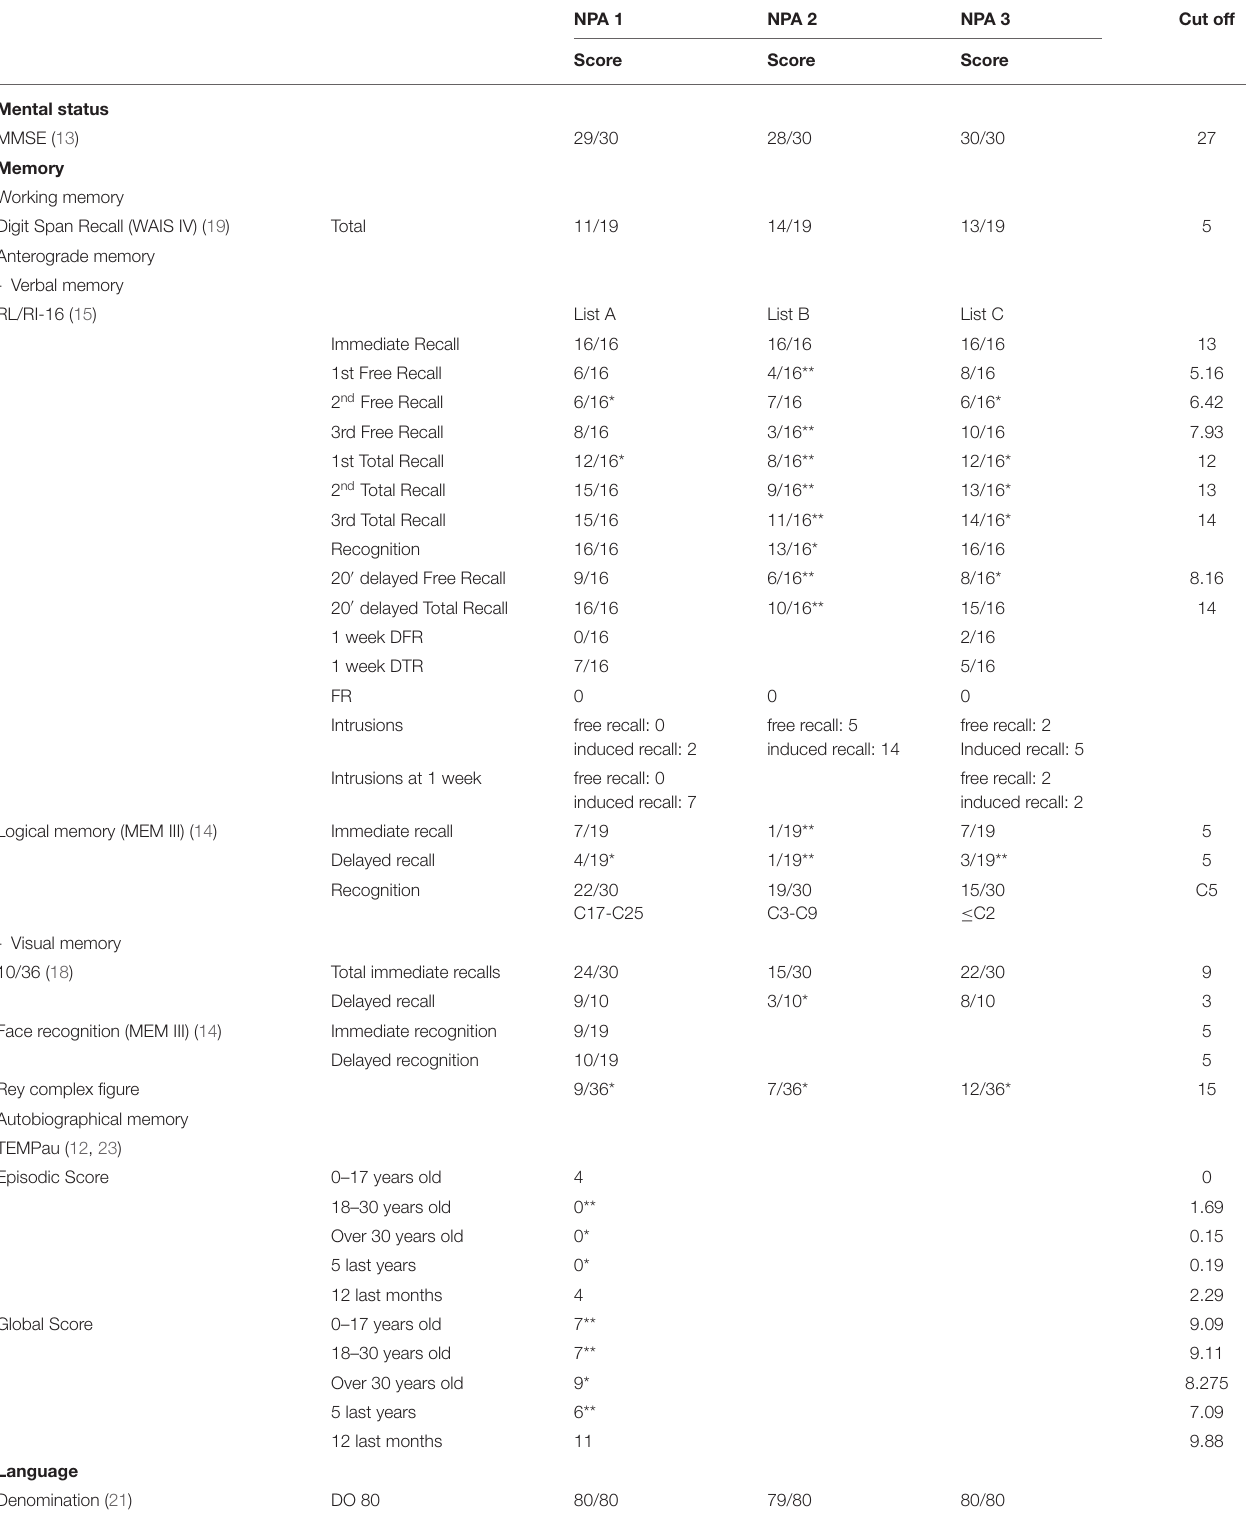
TABLE 1 | Neuropsychological